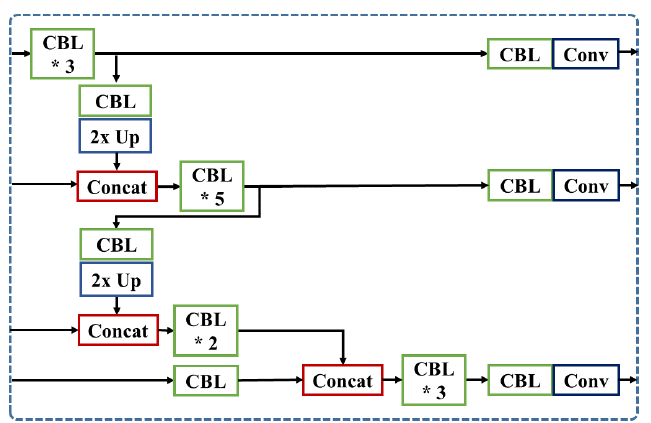
Figure 9. Detailed architecture of LCat. (’ ∗ ’ means the repetition of